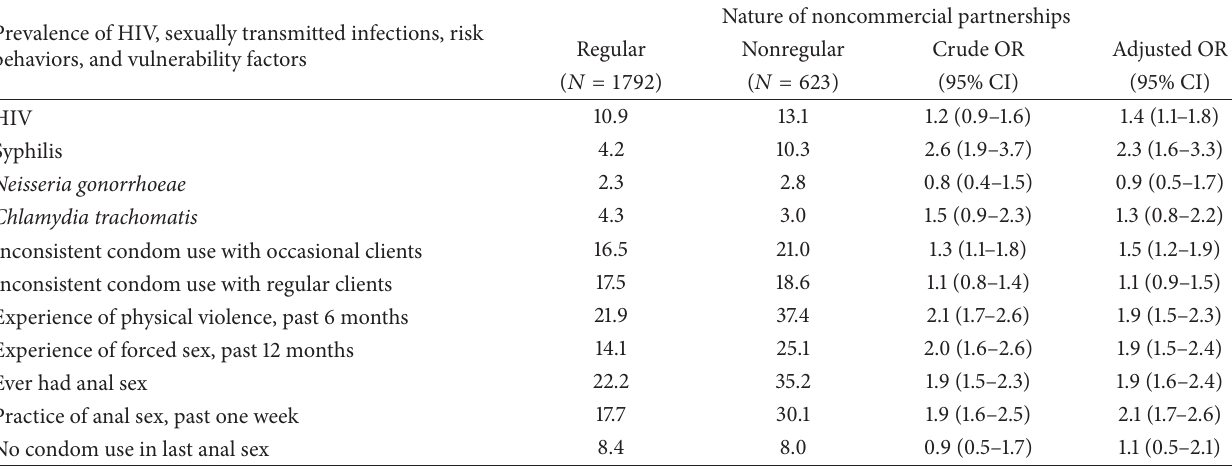
Table 3: Prevalence of HIV, sexually transmitted infections, risk behaviors, and vulnerability factors by nature of noncommercial Partner- ships, Andhra pradesh, 2009 ( 𝑁 = 2415